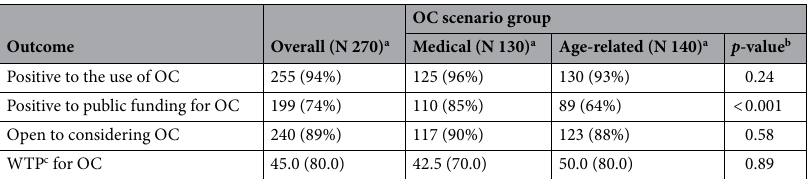
Table 2. Attitudes and willingness-to-pay for oocyte cryopreservation (OC) in a medical or age-related fertility preservation scenario. a N (%) or median (IQR). b Pearson’s Chi-squared test or Wilcoxon rank-sum test. c Willingness-to-pay expressed in thousand Swedish krona (K SEK).